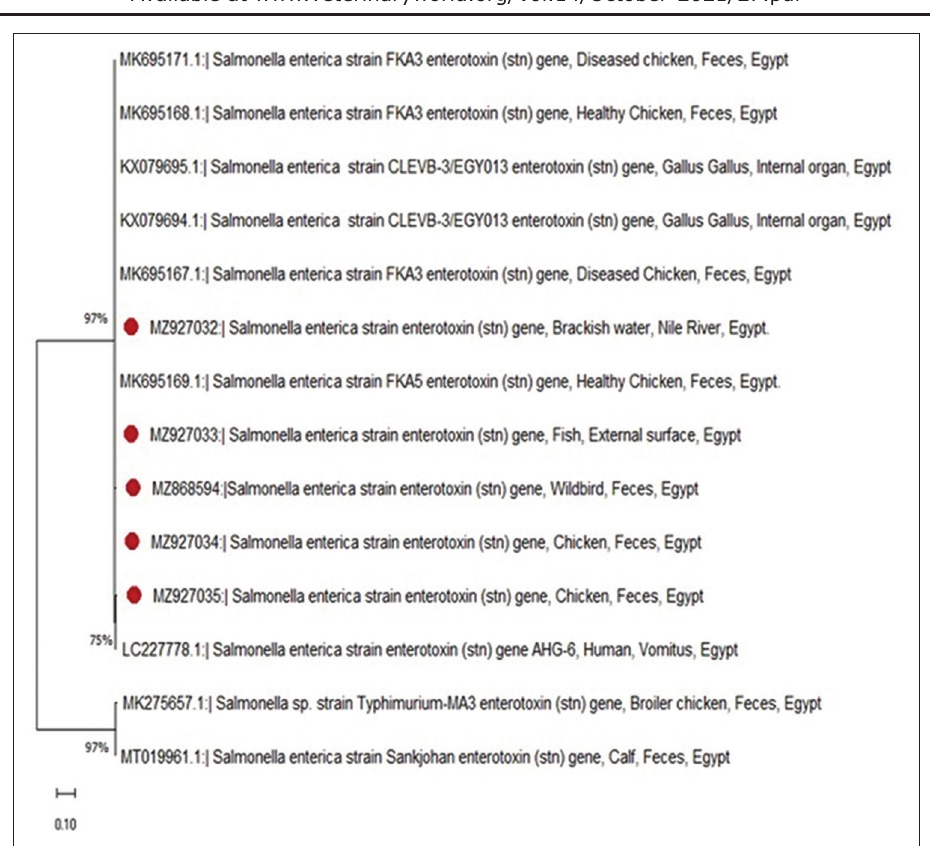
Figure-2: Neighbor joining phylogenetic tree with nucleotide sequences of 5 stn genes of Salmonella spp. The isolates used in the current study labeled with red color. The analysis was generated using neighbor-joining method with MEGA X software version